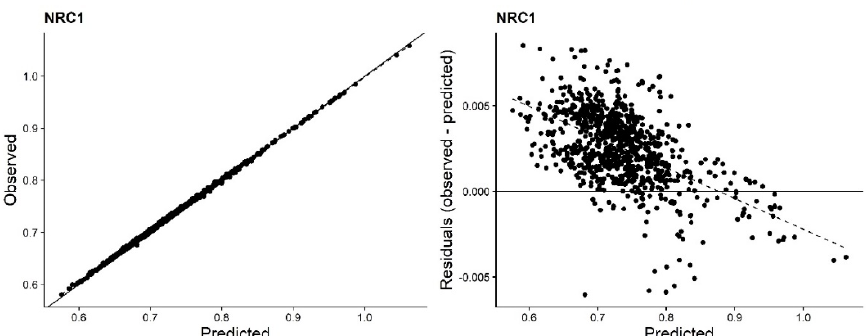
Figure 1. Plots of observed versus predicted milk energy (Mcal/L) and observed minus predicted (residual) versus predicted milk energy (Mcal/L) using Tier 1 equations. The dotted lines represent the regression lines. CSIRO, Commonwealth Scientific and Industrial Research Organization; Jap, Japan; NorFor, Nordic feed evaluation system (Scandinavia); NRC, National Research Council. Tier 2 equations, which used milk protein and milk fat as variables, were included in the NRC, NorFor, and INRA systems. All three Tier 2 equations showed high and similar predictivity, with R 2 = 0.98, RMSEP = 0.01, and CCC = 0.99. Although the mean and slope biases were significant, the bias was mostly random in the Tier 2 equations (Table 4). The Tier 2 models showed a positive residual when the predicted milk energy was low and a negative residual as the predicted value increased. The inflection point was 0.83, 0.67, and 0.68 Mcal/kg for the INRA, NorFor, and NRC equations, respectively (Figure 2).